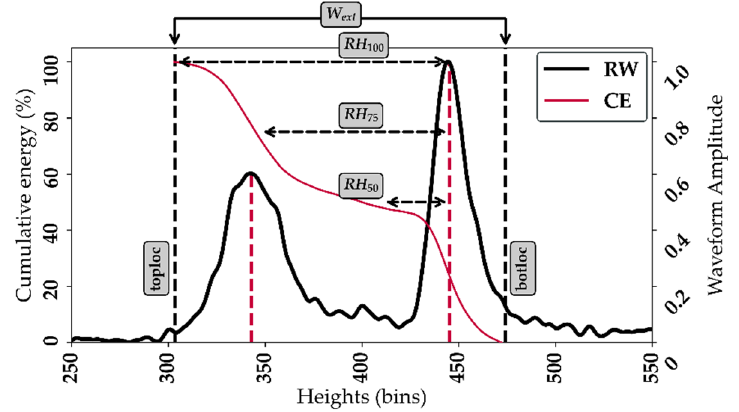
Figure 2. Example of an acquired GEDI waveform (RW) over an Eucalyptus stand ( H dom = 20.4 m; V = 129.6 m 3 ·ha − 1 ). The cumulative energy of the waveform (CE) between botloc and toploc and the corresponding relative heights ( RH n ) at different quantiles “ n ”. The left and right red dashed lines represent, respectively, the position of the vegetation ( Vloc ) and ground peaks ( Gloc) . Note that 1 ns corresponds to 15 cm sampling distance in the waveform. The waveform amplitudes are counts from the analog to digital converter (ADC) on the instrument and normalized to be between 0 and 1.